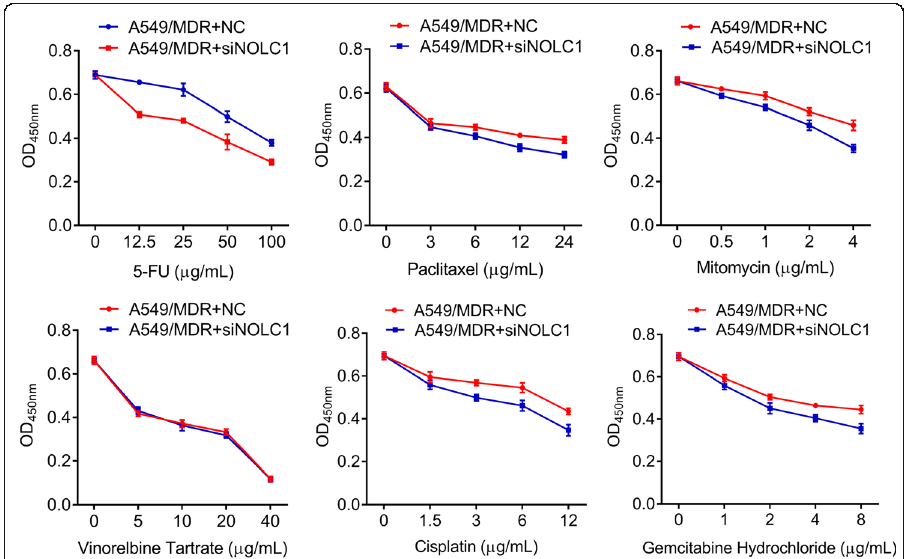
Fig. 4 NOLC1 knockdown significantly decreased cell viability of A549/MDR cells after multidrug treatments. A549/MDR cells were transfected with siNOLC1 or NC for 48 h after treatment with 5-FU, paclitaxel, mitomycin, vinorelbine tartrate, DDP and gemcitabine hydrochloride. CCK-8 assay was used to assess the